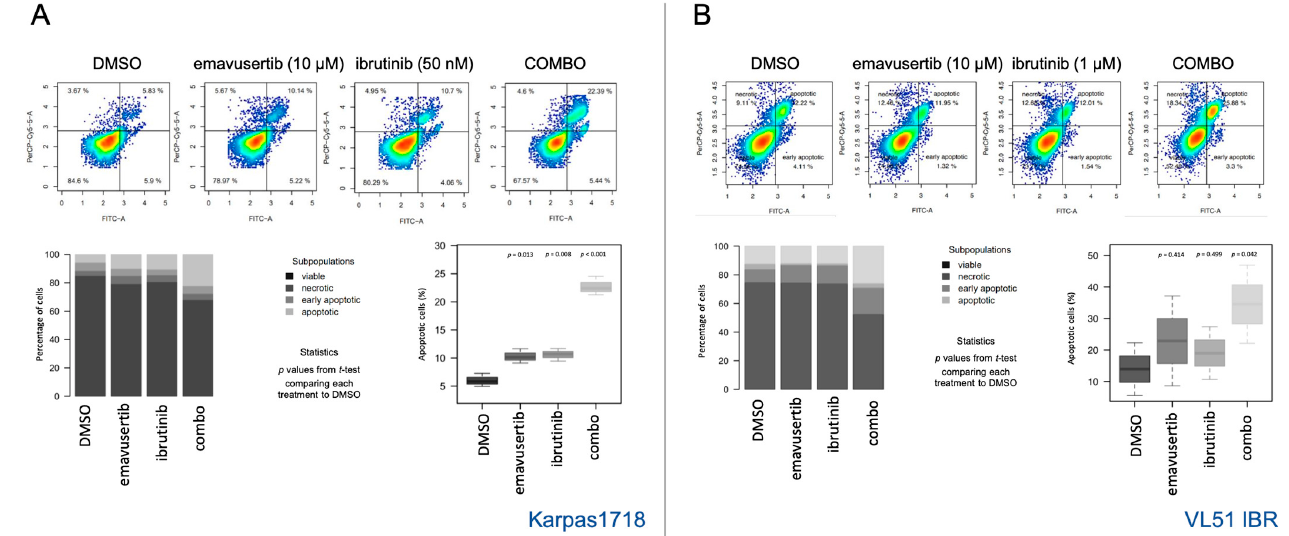
Figure 7. Addition of emavusertib to ibrutinib induces apoptosis. Apoptosis induction after ema- vusertib (10 μ M) alone or in combination with ibrutinib (72 h) in ( A ) K1718 and ( B ) VL51 ibrutinib resistant line. Ibrutinib doses were selected based on the IC50 values in the parental lines (50 nM in K1718, 1 μ M in VL51). Data represent the average of two independent experiments. Error bars for standard deviation of the mean. p for nominal p -value from t-test comparing each treatment to con- trol (DMSO).